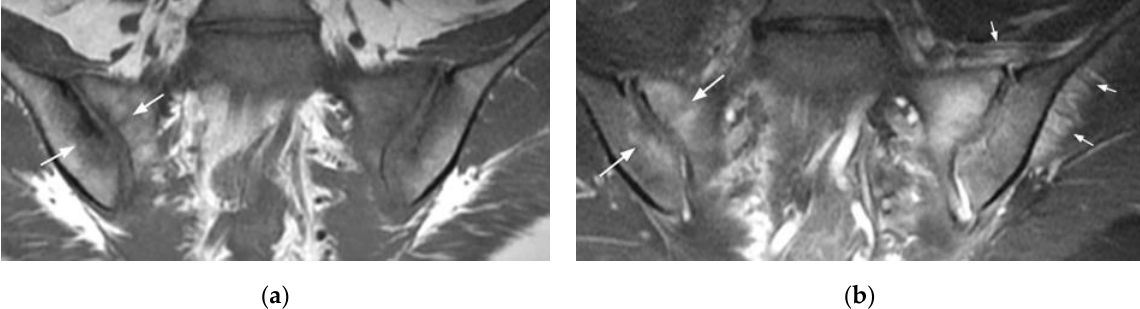
Figure 5. Post-partum changes (right SIJ) and infectious sacroiliitis by staphylococcus aureus (left SIJ) (coronal oblique T1- ( a ) and fat-suppressed T2- ( b ) weighted images). Right post-partum changes include mild sclerosis surrounded by BME (long arrows). On the left side, an extensive BME, hypointense on T1-, and hyperintense on T2-weighted images is associated with abundant joint fluid and extra-articular edema (small arrows).